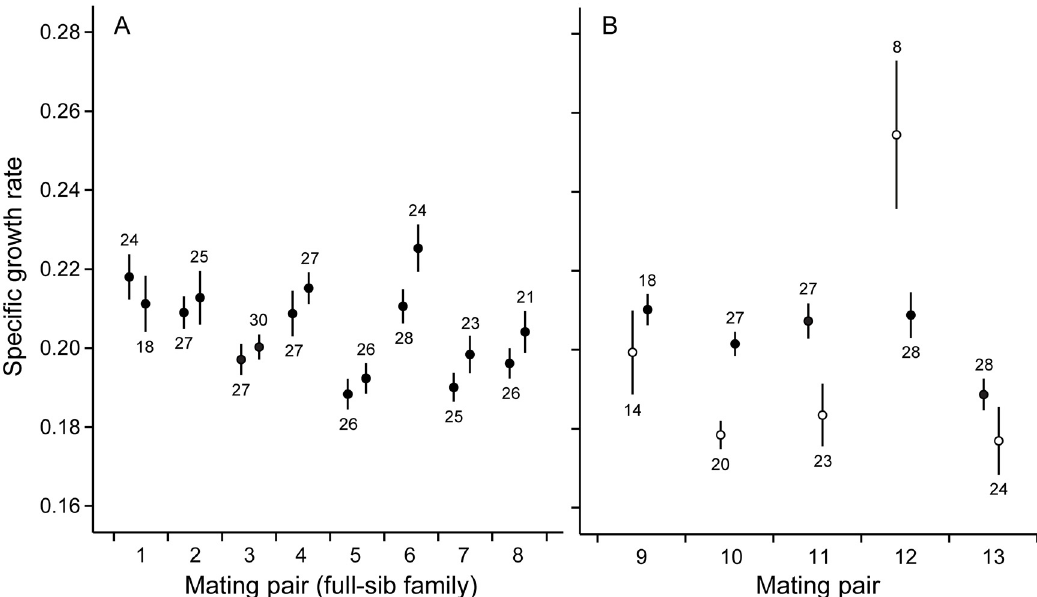
Fig 3. Specific growth rate of snails during the last five weeks of the study. (A) Mean ( ± SE) of individuals produced by different dams in mating pairs of parental snails in which both dams reproduced through outcrossing (individuals produced by each pair are full-sibs). (B) Mean ( ± SE) of individuals produced by different dams in mating pairs in which one dam reproduced through self-fertilization (open circles).